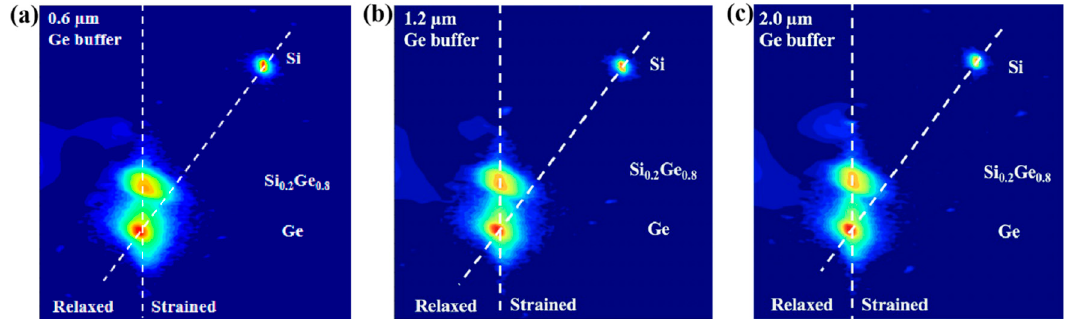
Figure 5. HRRLMs around (113) reflection of strained Si 0.2 Ge 0.8 /Ge stack layers grown on a Ge buffer layer with thicknesses of ( a ) 0.6, ( b ) 1.2 and ( c ) 2.0 µm.